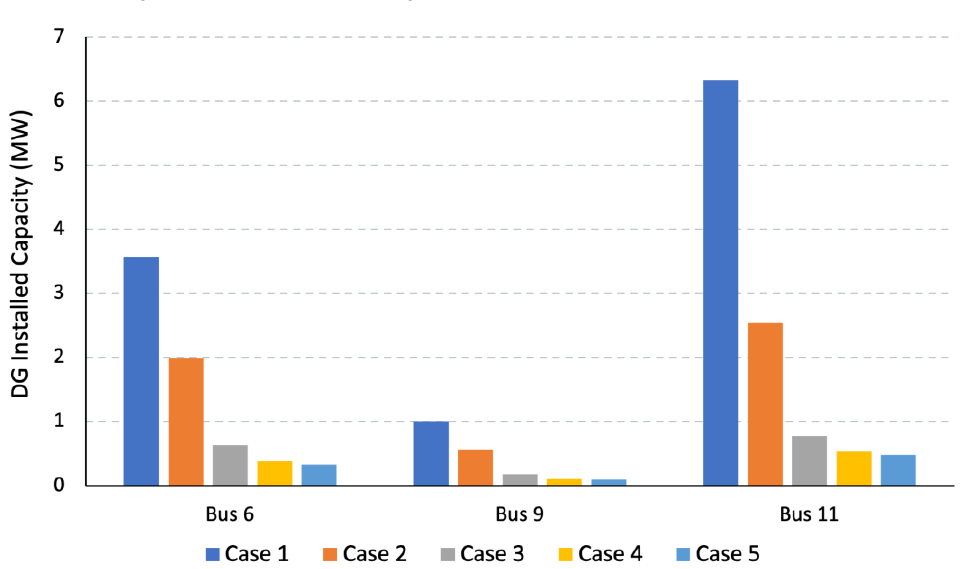
Figure 6. DG generation by bus and by case.